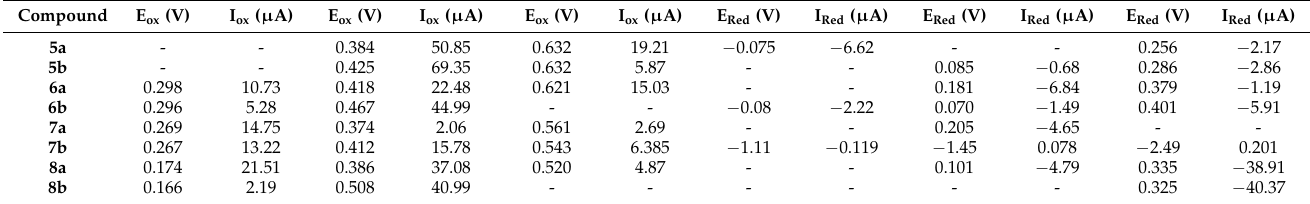
Table 7. Comparative presentation of the variation of peak currents and oxidation/reduction potentials for the tested compounds.